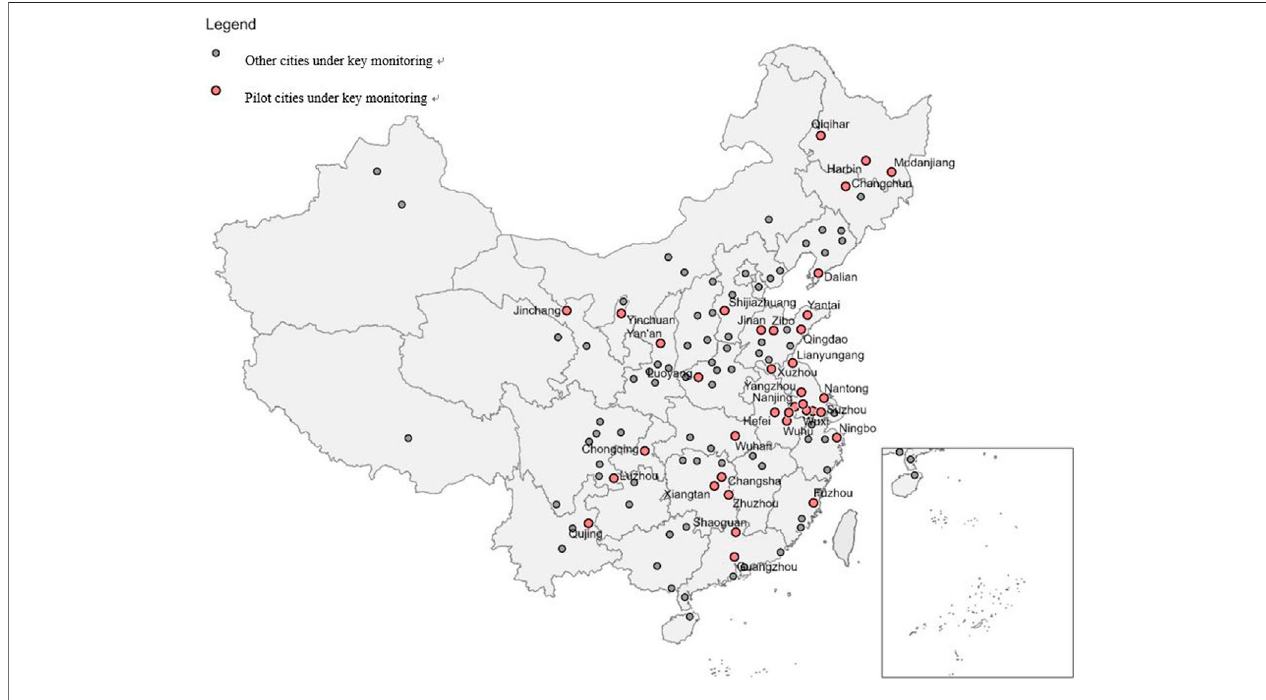
FIGURE 1 | Locations of the pilot cities.